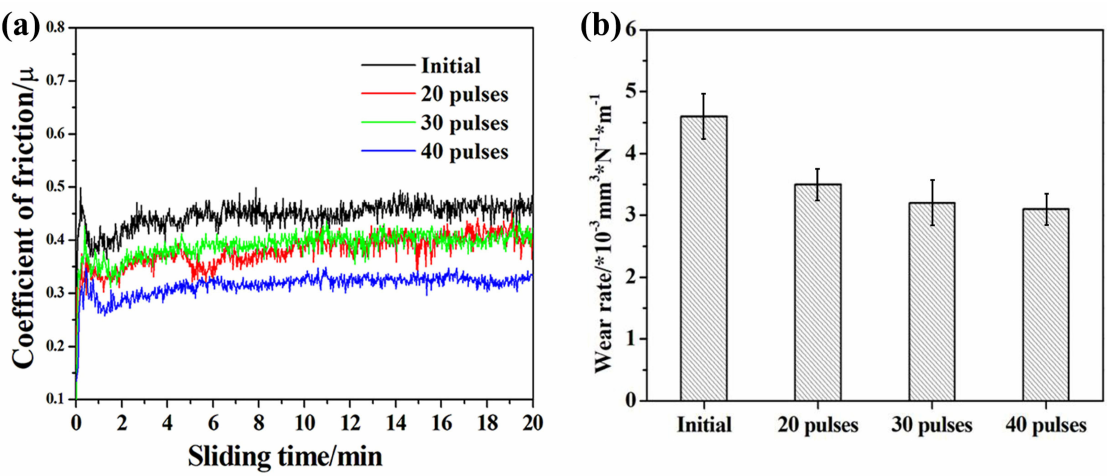
Figure 7. Tribological behavior of initial and Nb-alloyed samples. ( a ) Coefficient of friction; ( b ) Wear